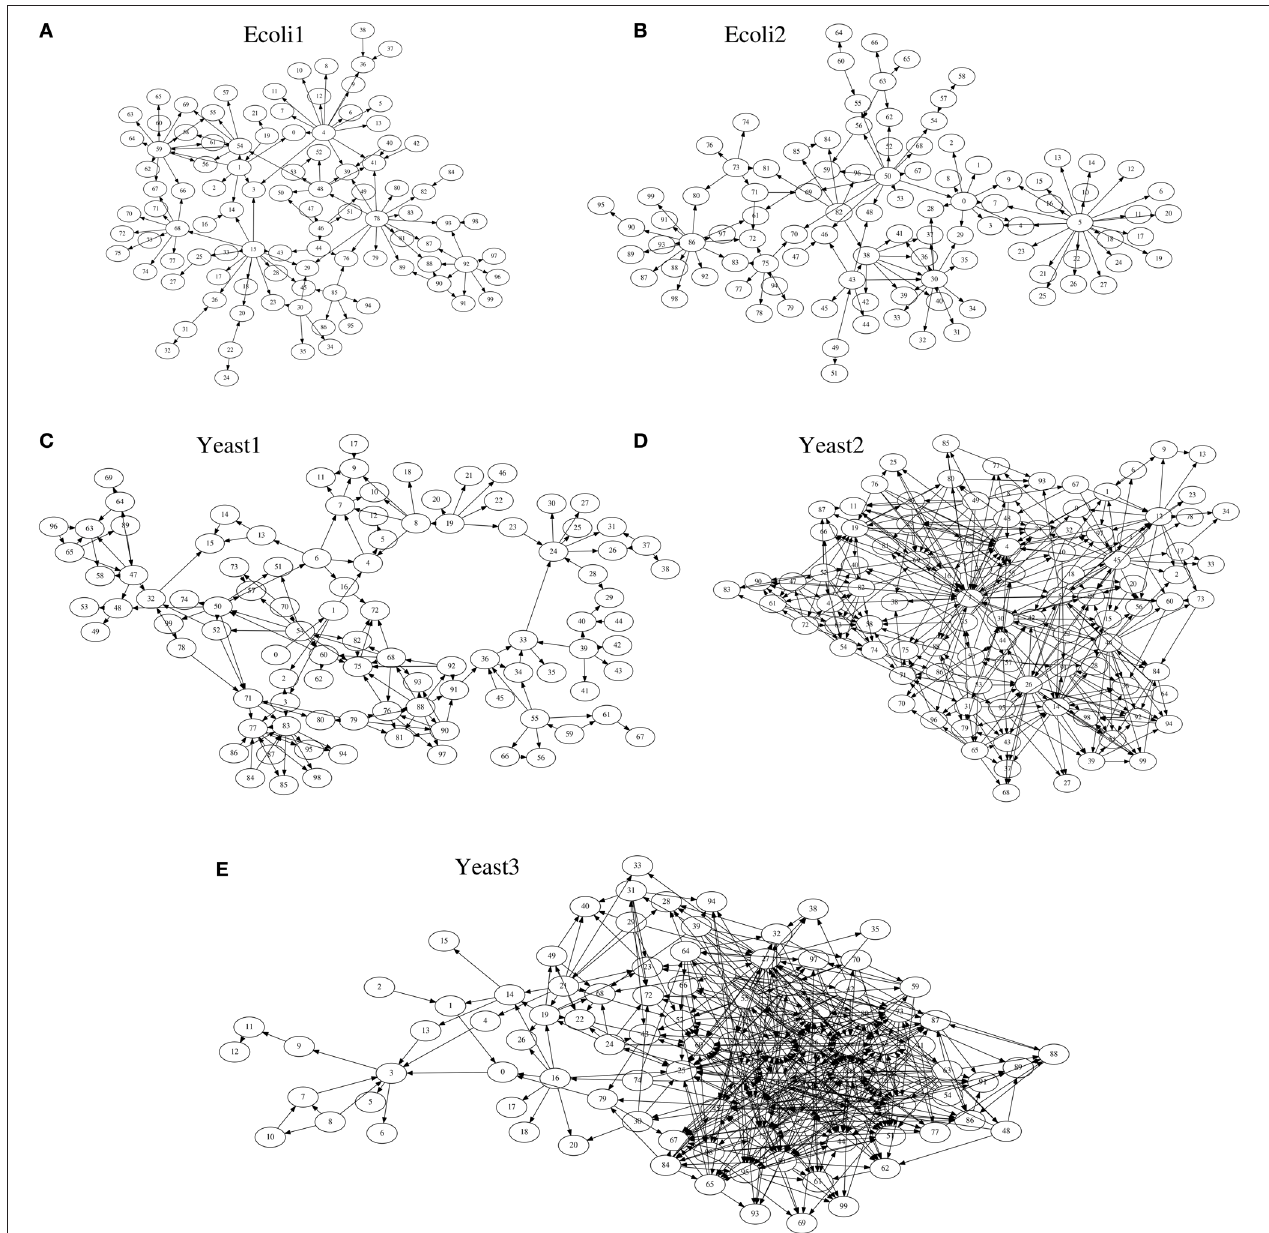
FIGURE 3 | The network structures of (A) Ecoli1, (B) Ecoli2, (C) Yeast1, (D) Yeast2, and (E) Yeast3.